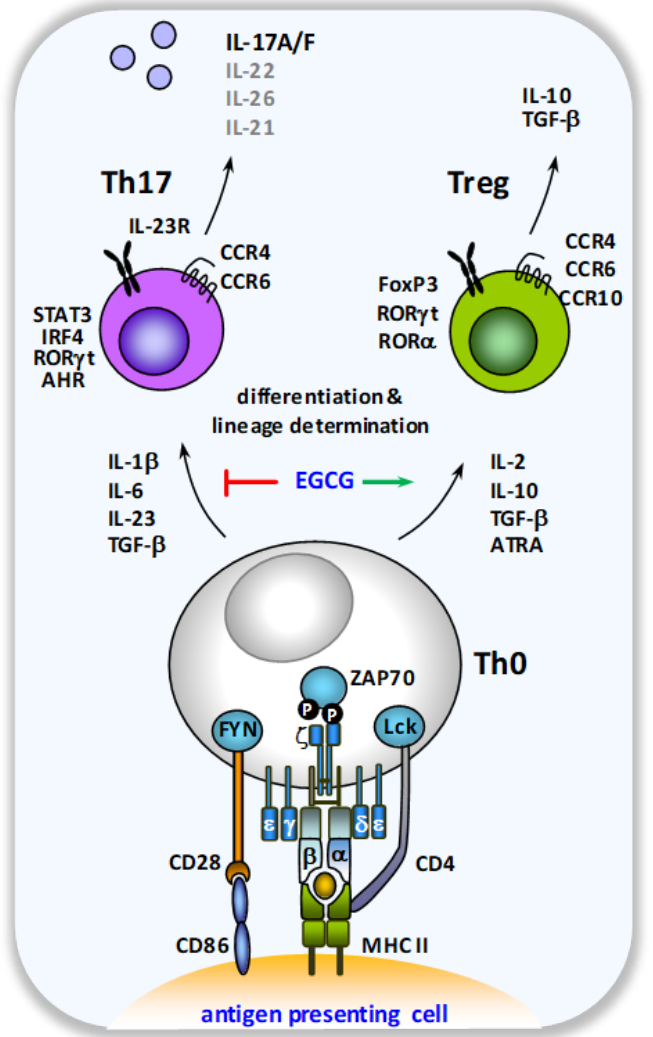
Figure 3. Schematic overview of the modulation of Th cell lineage development by EGCG . When activated by antigen-presenting cells, naïve CD4 + T cells can differentiate into various effector cell subtypes, depending on the local cytokine milieu. In the presence of an inflammatory cytokine milieu, dominated by the presence of IL-1 β , IL-6, IL-23 and TGF- β , Th17 lineage determination is favored with the concomitant production of the Th17 cell signature cytokine IL-17A.